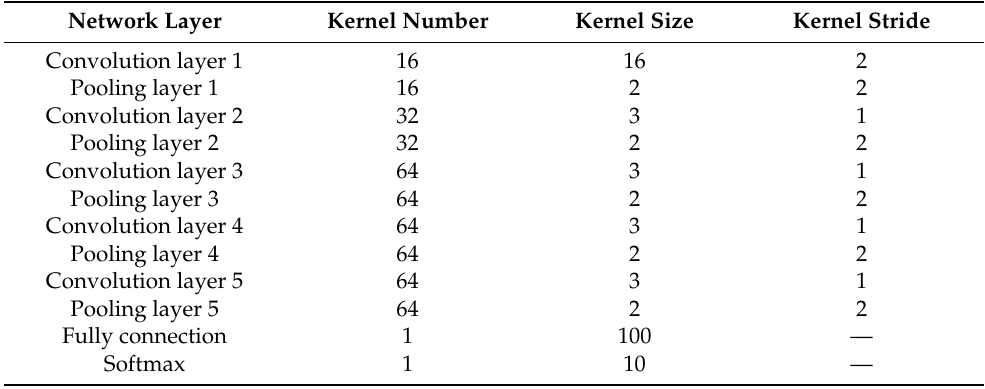
Table 2. The parameters of the constructed 1DCNN.